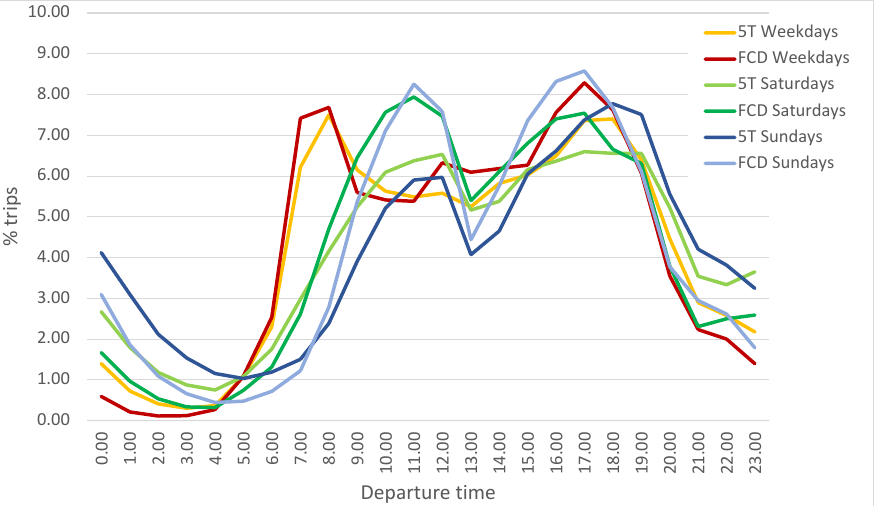
Figure 2. Percentage distributions of daily trips for the different time slots (comparison between FCD and 5T data).